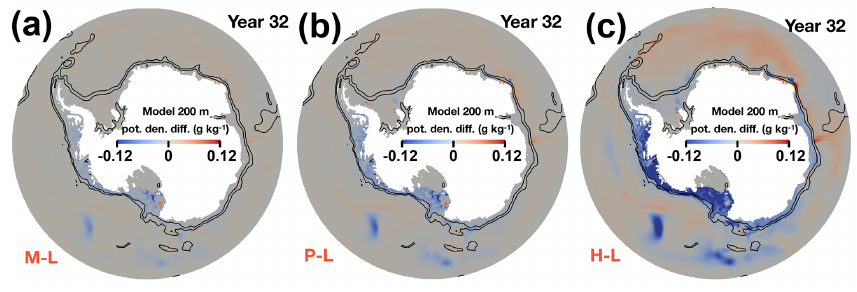
Figure 9. January mean potential density difference for (a) MMELT-LMELT (M–L), (b) PRS-LMELT (P–L), and (c) HMELT-LMELT (H–L) for year 32 at 200m depth. The bathymetry contours of 1000 and 2500m are shown with black lines.